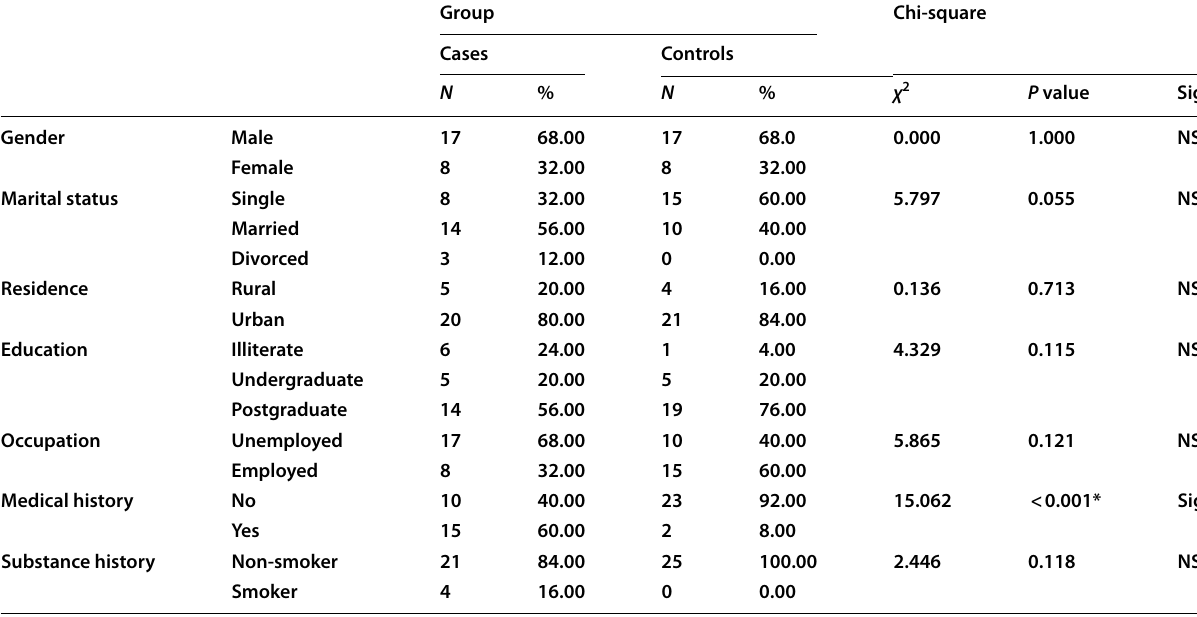
Table 1 The demographic and clinical data of cases and controls